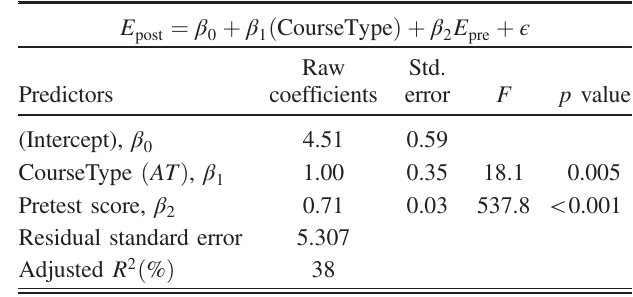
TABLE V. Results of linear regression (ANCOVA) for wom- en ’ s post-test scores while controlling for pretest